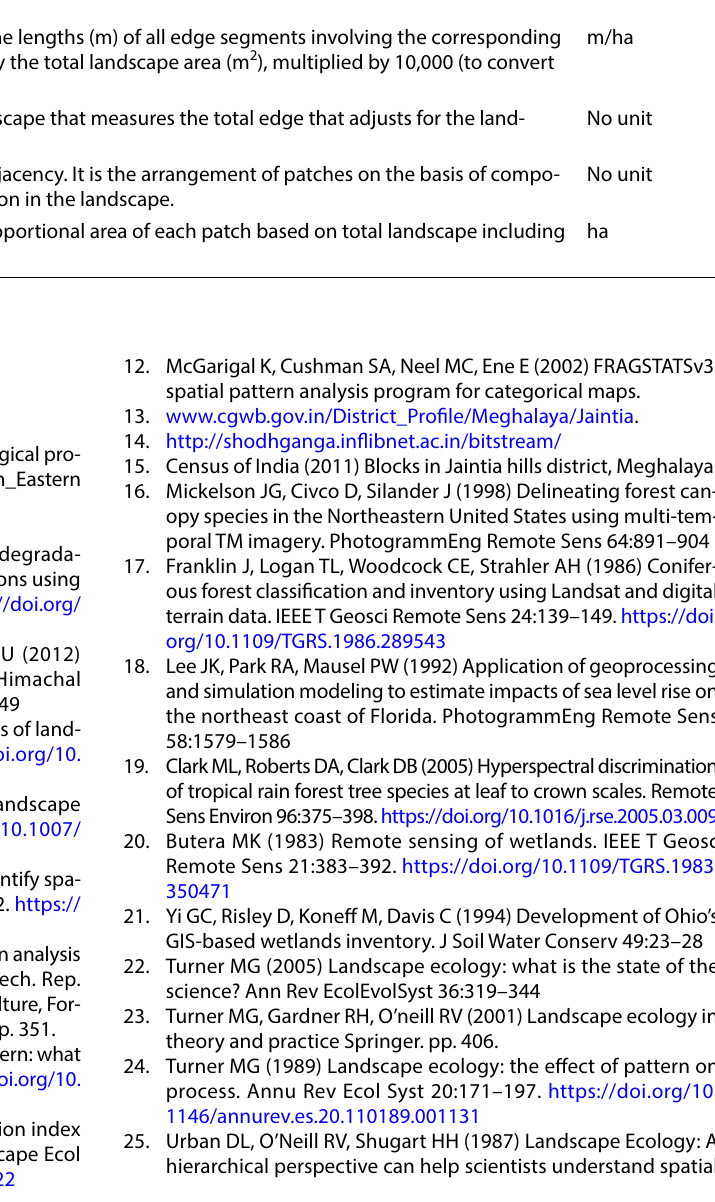
Table 13 List of landscape metrics used Metrics Description Units Class area Tells about how much landscape is comprised of a particular patch type Percentage of landscape Number of patches Patch density Ratio of number of patches and the area Largest patch index